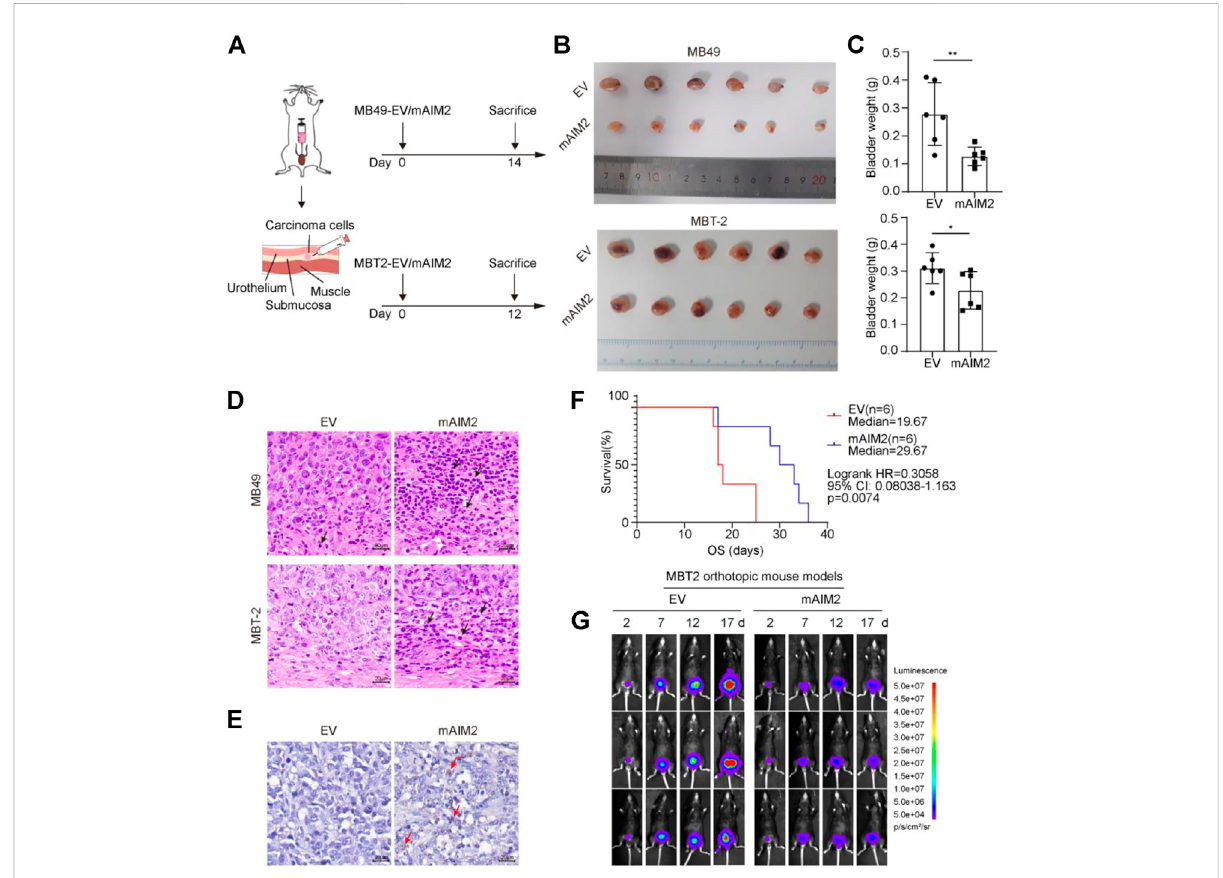
FIGURE 2 Mice transplanted with mAIM2-overexpressed MBT-2 cells show prolonged survival and delayed tumor progression. (A) Experimental schematic. Mice were transplanted with 1.5 × 10 4 mAIM2-overexpressed MB49 or MBT-2 bladder carcinoma cells and the indicated control cells on day 0 and sacri fi ced on day 14 or 12, respectively. (B) Images of bladders from the indicated groups. (C) Bladder weights of orthotopic tumors from the indicated groups. (D) Representative pictures of H and E staining of orthotopic MB49 and MBT-2 transplanted BLCA model. In fl ammatory cells signi fi cantly in fi ltrate mAIM2-overexpressed tumors. Black arrows indicate in fl ammatory cells. (E) Representative pictures of immunohistochemistry (IHC) staining of CD11b for MBT-2 xenografts. CD11b + cells were signi fi cantly enriched in mAIM2-overexpressed tumors. Red arrows indicate in fl ammatory cells. (F) Survival curves of mice transplanted with mAIM2-overexpressed MBT-2 cells or the control. (G) Fluorescence of mAIM2-overexpressed MBT-2 cells or the control cells after orthotopic transplantation were monitored by IVIS at indicated days. Data in (C) are presented as the means ± SD. p -values in (C) were calculated using the student ’ s t -test. Survival rate (F) is compared by